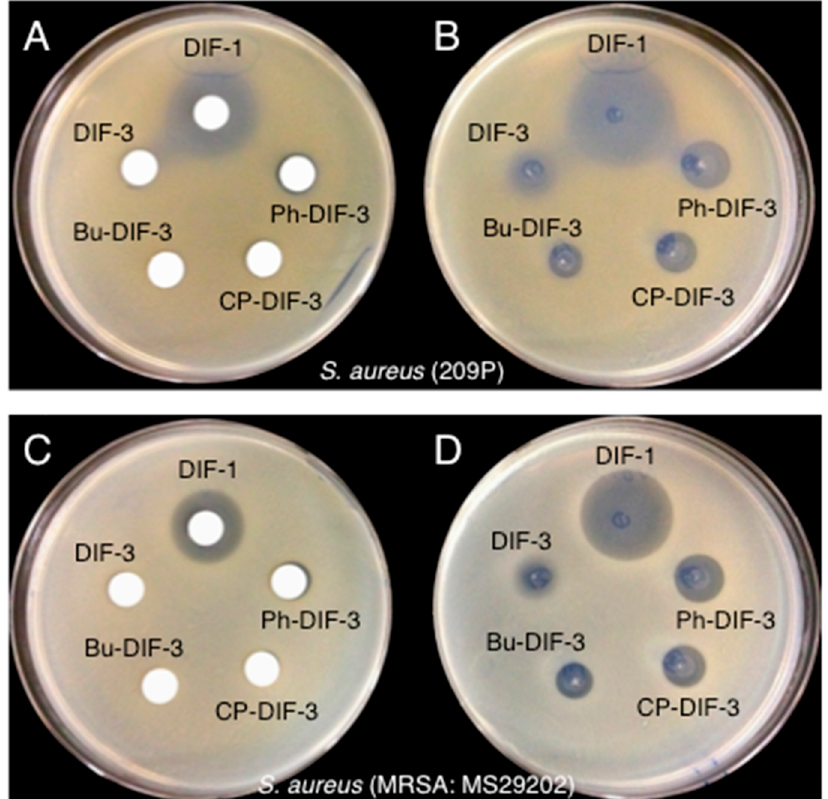
Figure 3. Effects of DIF derivatives on the growth of MSSA and MRSA on agar. Paper discs were placed on MHB agar plates that contained ( A ) MSSA (strain 209P) or ( C ) MRSA (MS29202); each paper disc was impregnated with 2 µL of a 10 mM solution of the indicated DIF derivative. In parallel, 2 µL of a 10 mM solution of the indicated DIF derivative was placed directly on MHB agar plates that contained ( B ) MSSA (209P) or ( D ) MRSA (MS29202). After incubation for 20 h at 37 °C, bacterial growth-inhibition zones around the discs were noted.